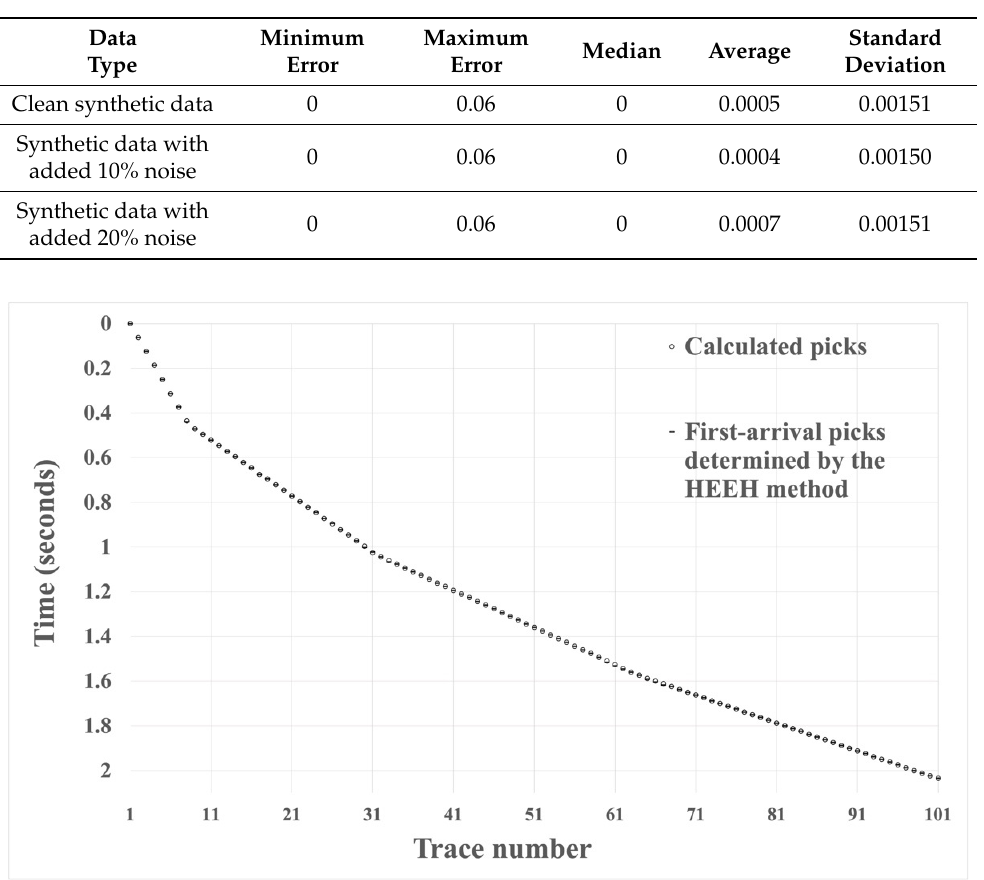
Figure 6. First arrival picks determined by the HEEH method and calculated from the model on the clean synthetic data.